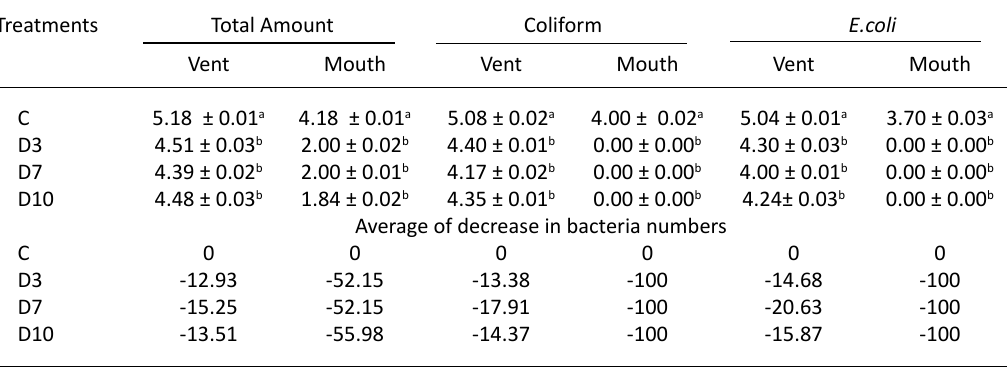
Table 1. Effects of microsafe spraying on average on bacteria counts in mouth and Vent of birds in 14 days ± SE (CFU/g)